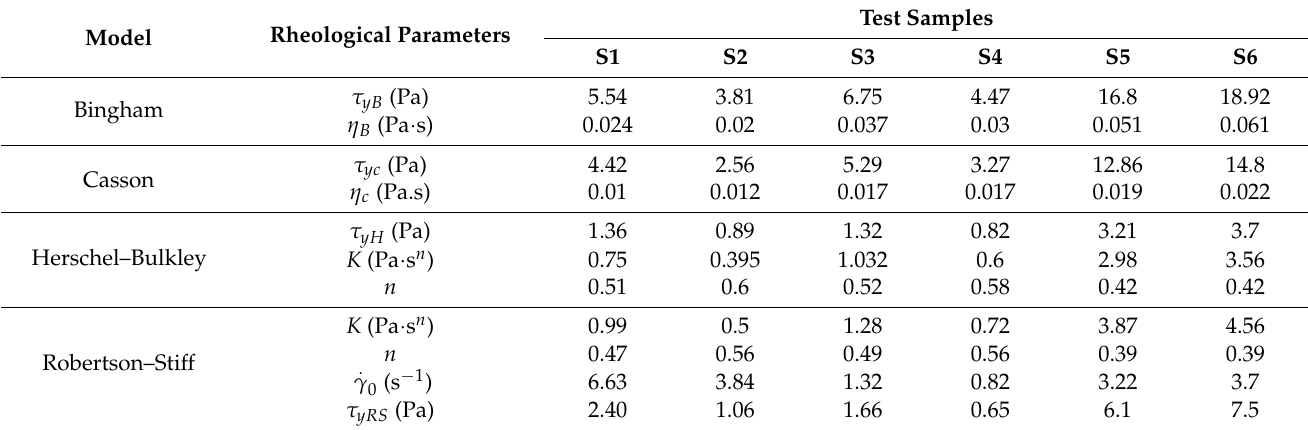
Table 2. Constant parameters for rheological